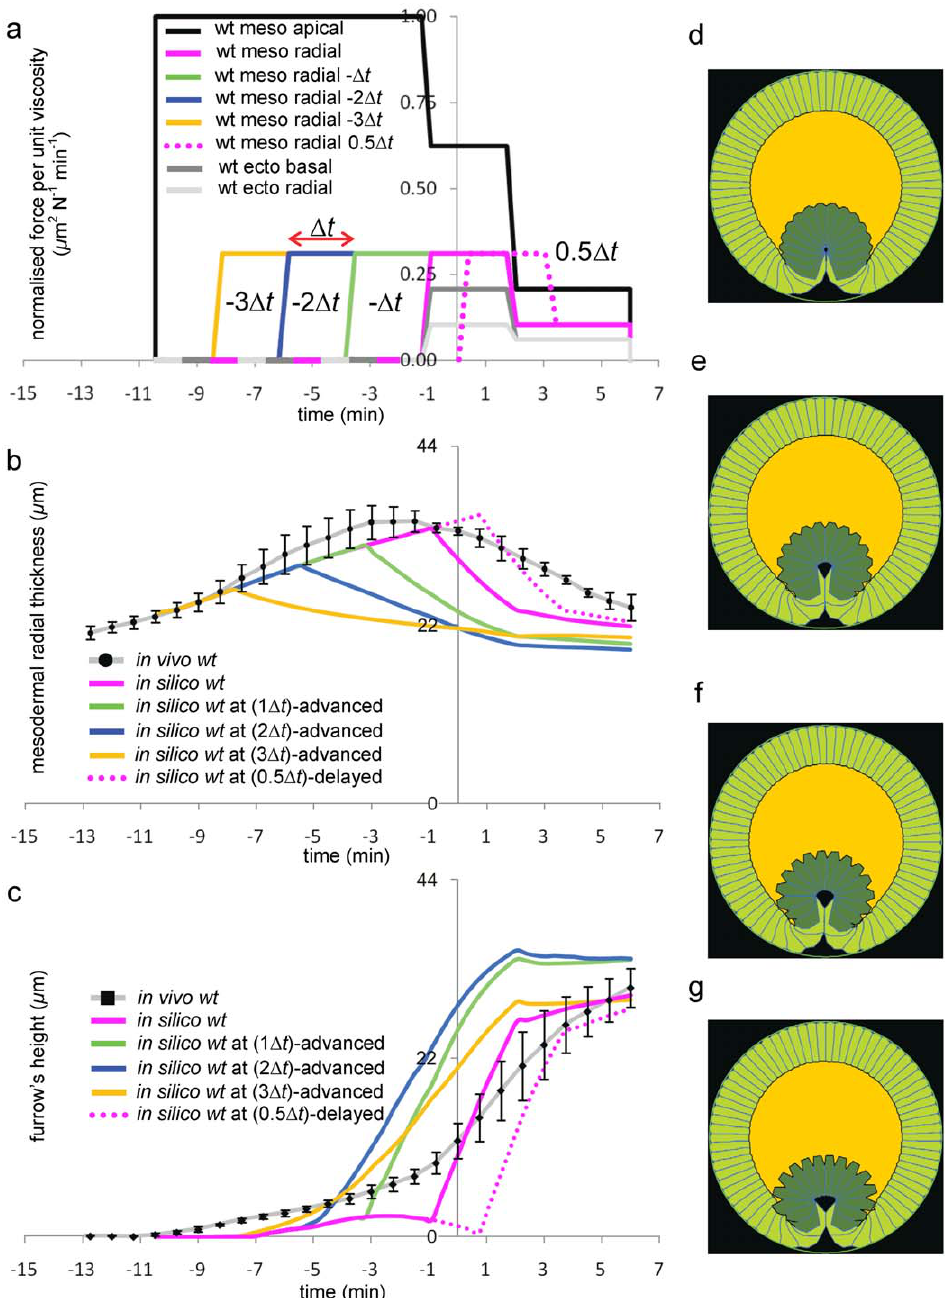
Figure 8. Meso-radial time study. The quantitative effects of anticipating the onset of mesodermal radial shortening with respect to the wild type case reported in Fig. 3, while keeping the remaining force trends unchanged (Fig. 3c). ( a ) Force trend curves labelled by { D t , { 2 D t , { 3 D t and 0 : 5 D t illustrate the case where meso-radial movement was respectively advanced at t= 2 3.48 min, t= 2 5.8 min, t= 2 8.12 min and delayed at t=0.58 min with respect to the wt case (where meso-radial movement onsets at t= 2 1.2 min, as shown in Fig. 3c). ( b–c ) Changes in the onset time of this movement with respect to the others have significant impact on furrow’s height h, which increases with the anticipation of the movement. The average mesodermal thickness (cid:2) MM decreases with the anticipation of the movement in that mesodermal cells start shortening earlier. ( d–g ) Final phenotypes (t=6 min) corresponding to wild type with mesodermal radial movements respectively delayed by 0 : 5 D t (dotted lines in panels a–c) and advanced by { D t , { 2 D t and { 3 D t . doi:10.1371/journal.pone.0034473.g008 standard error of the data and quantifies how close the model is to the in vivo data points (the lower RMSSD the better the Custom software was used to generate a reference mesh that agreement) [26]. was overlaid and adjusted manually to fit the first image of each movie of the embryo. Automated and manual methods were used